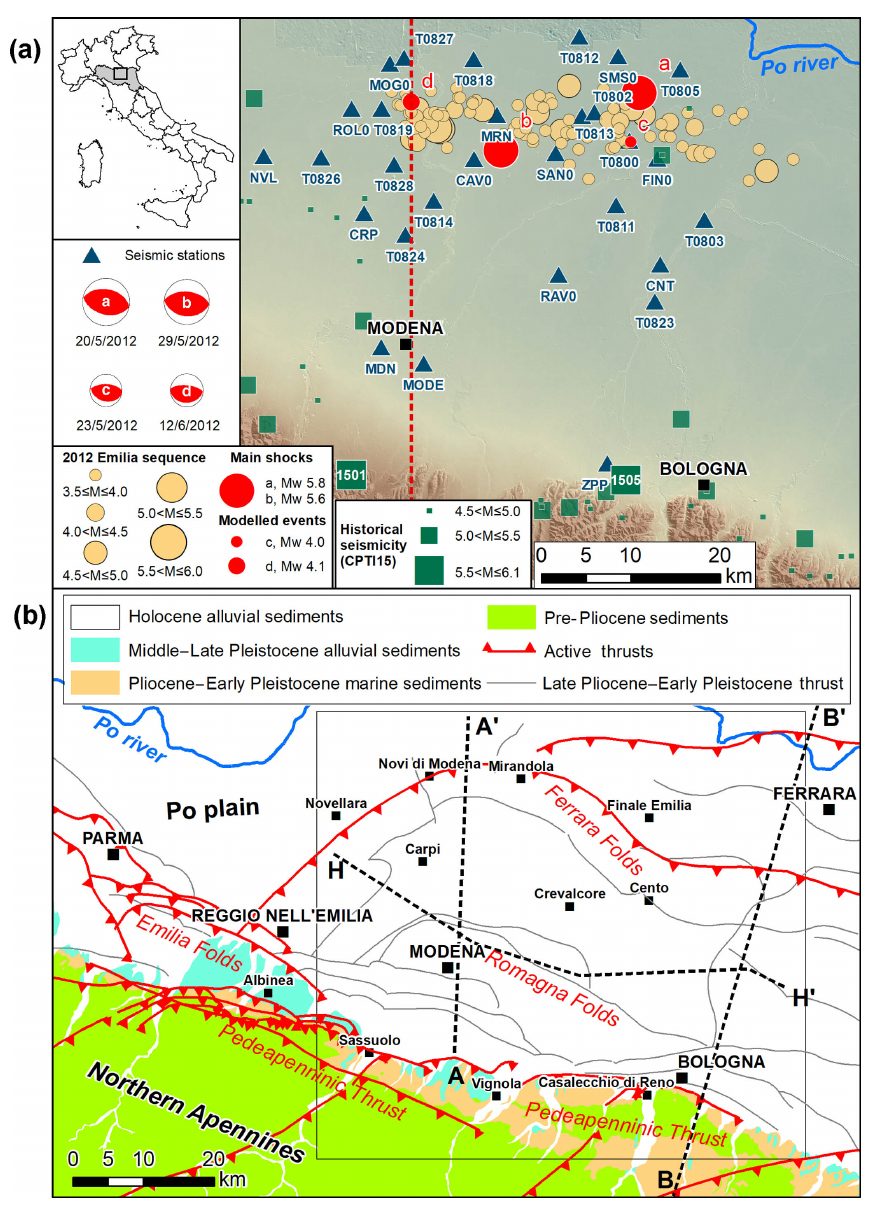
Figure 1. (a) Study area with historical seismicity (CPT15; Rovida et al., 2016), 2012 Emilia sequence epicenters ( M ≥ 3 . 5), tempo- rary/permanent seismological stations and trace of vertical section of Fig. 11. (b) Geological sketch of the study area, with traces of the three deep geological sections represented in Fig.